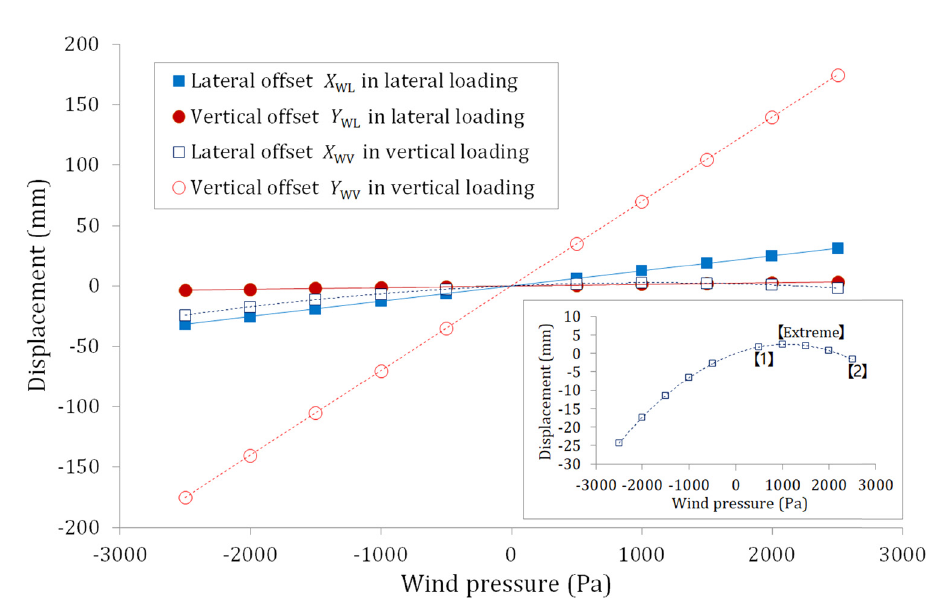
Figure 9: Fitting curve between 2D nodal displacement and wind